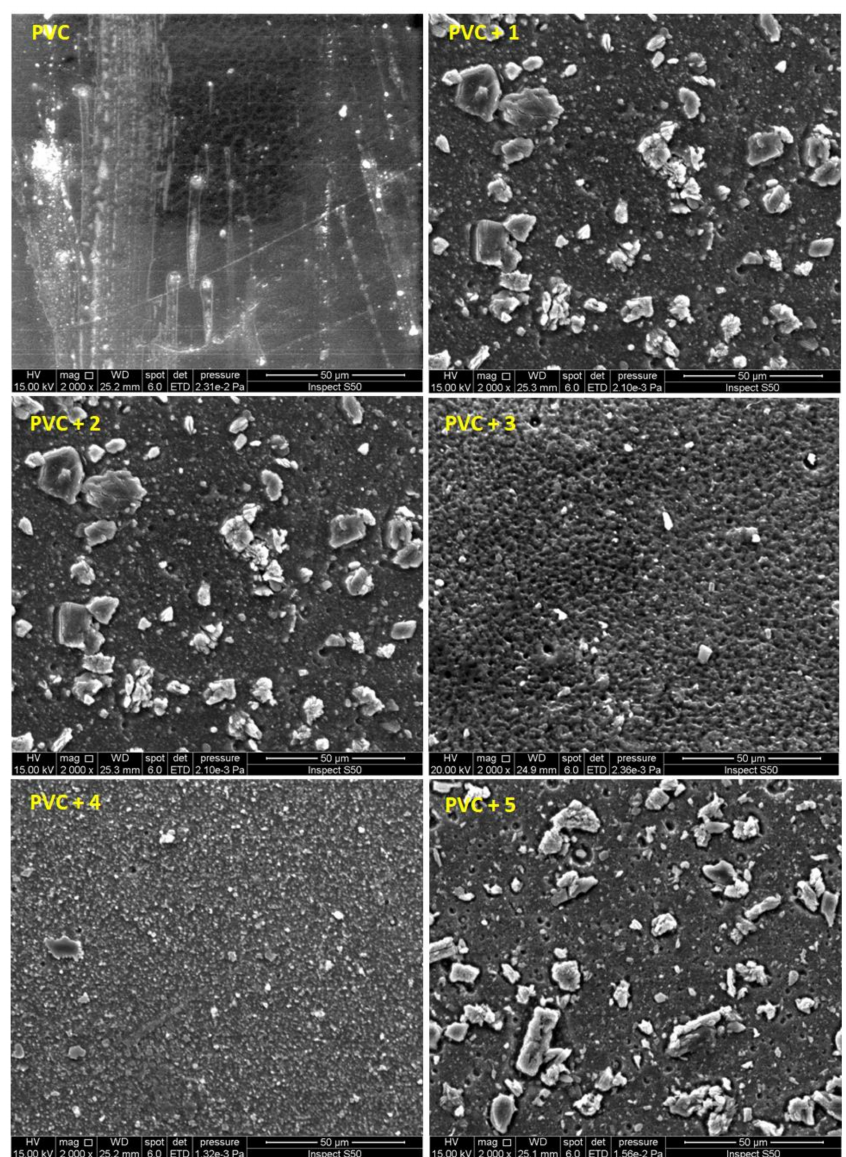
Figure 11. Scanning electron microscopy (SEM) images (50 µ m) of PVC after